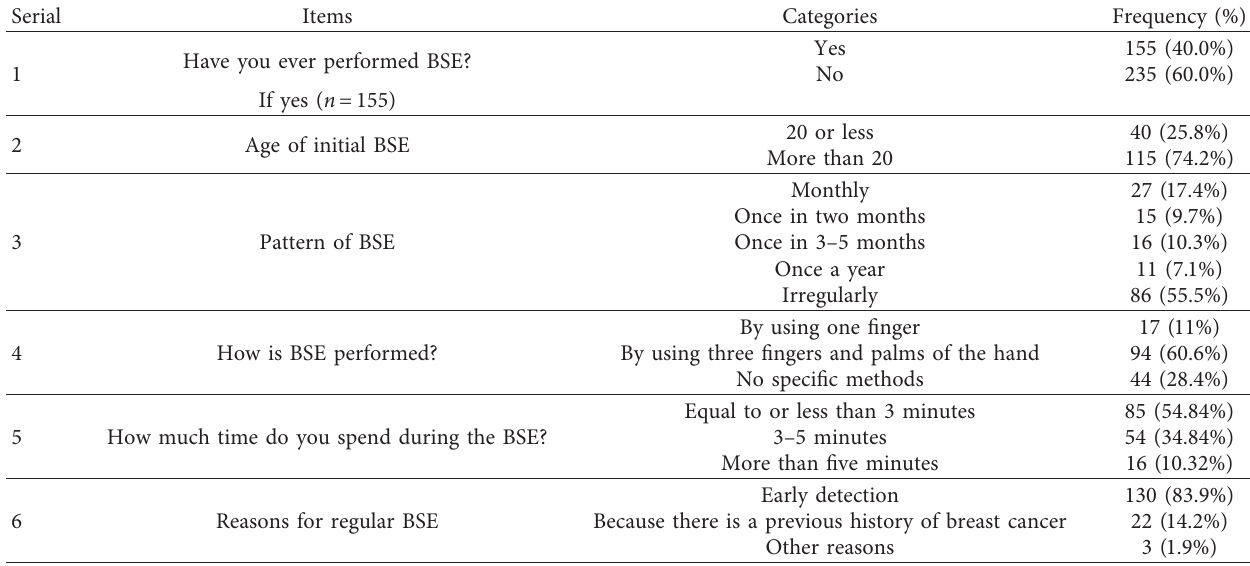
Table 3: Respondents practice and reasons for doing